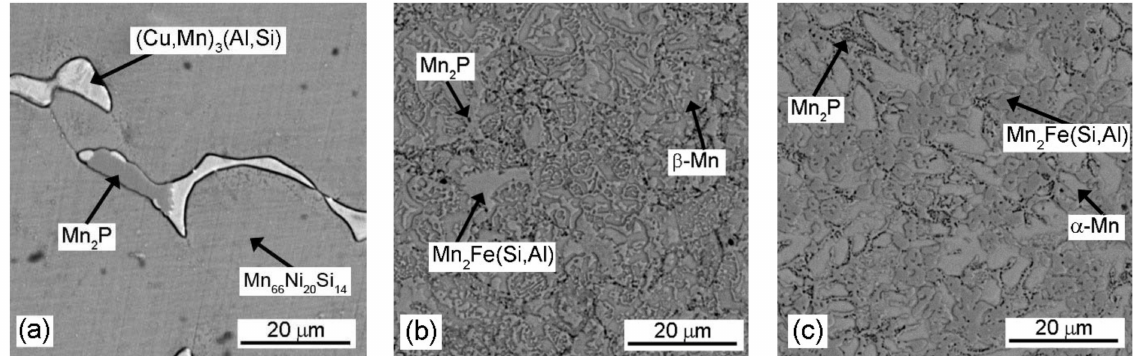
Figure 4. Optical micrographs of Mn-based alloys: ( a ) 0% Al, ( b ) 10% Al, and ( c ) 20%